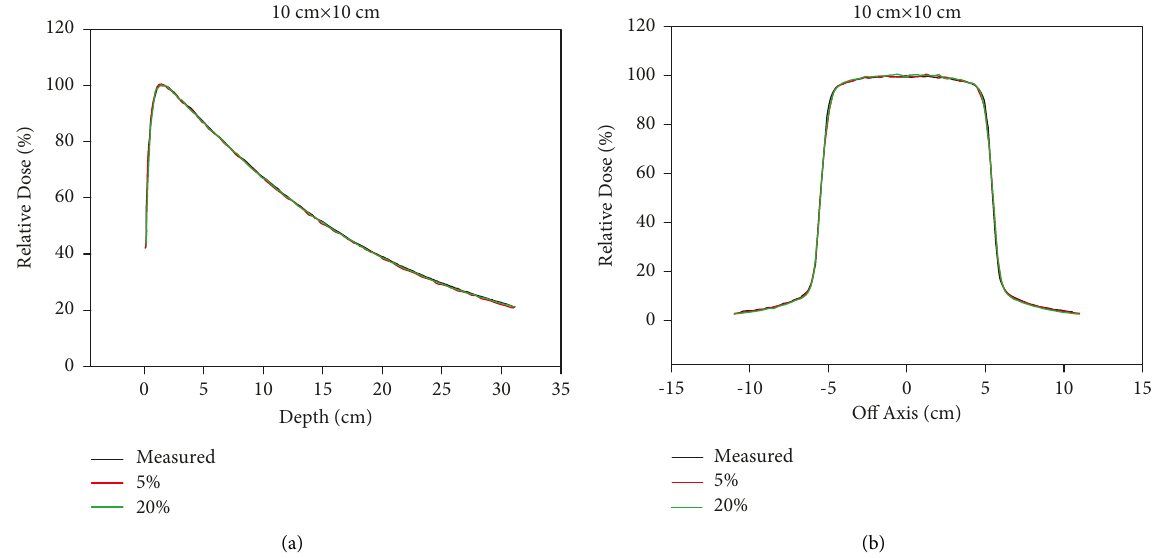
Figure 6: (a) The influence of the energy spread of incident electrons on PDDs for 10 × 10cm 2 field. (b) The influence of energy spread of incident electron on OARs for 10 × 10cm 2 field at 10 cm depth. Red curve represents the dose curve when the energy spread is 5%, the green curve represents the dose curve when the angular divergency is 20%, and the black curve represents the measured dose